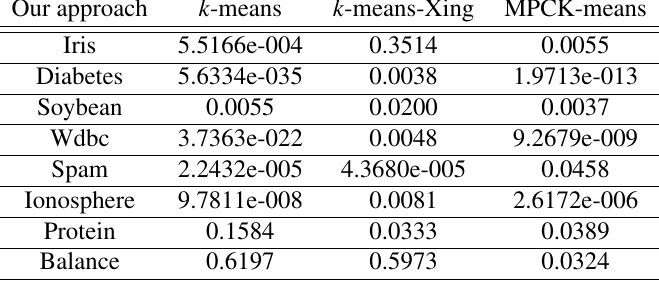
Table 3. t -test under RS index